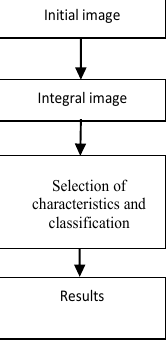
Figure 3. Block diagram of the detection process.